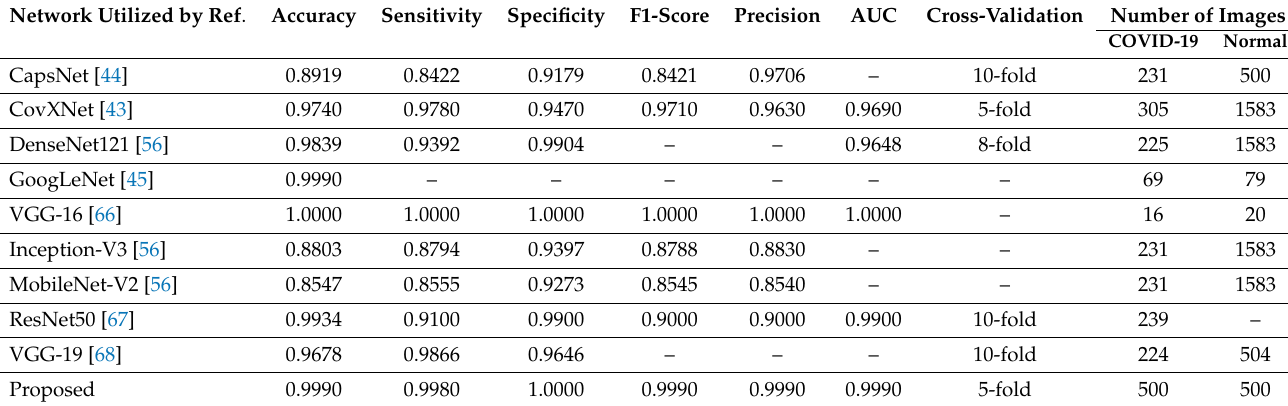
Table 8. Comparative analysis of binary classification of COVID-19 for the similar utilized dataset.